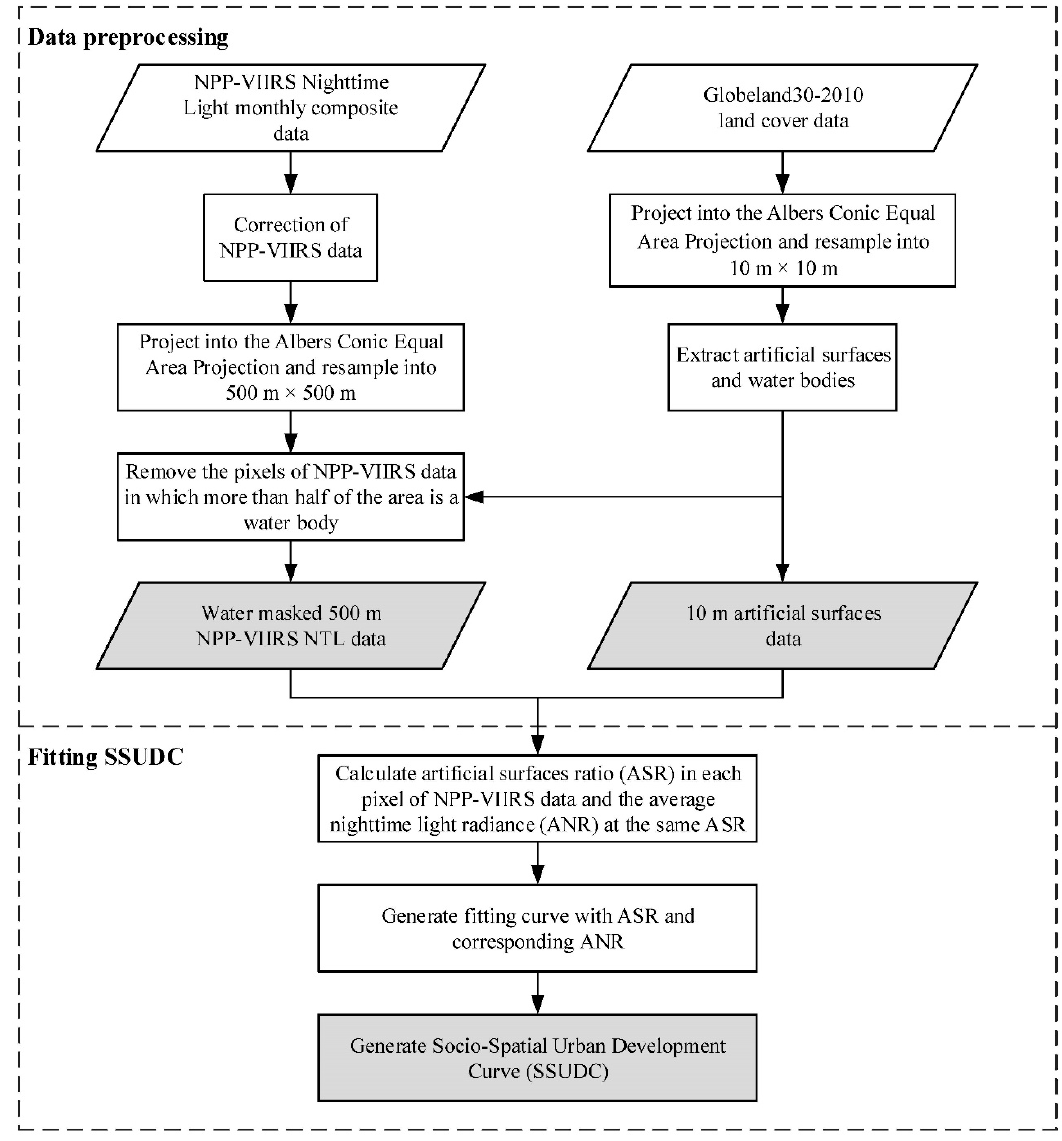
Figure 3. Flowchart of SSUDC generation.